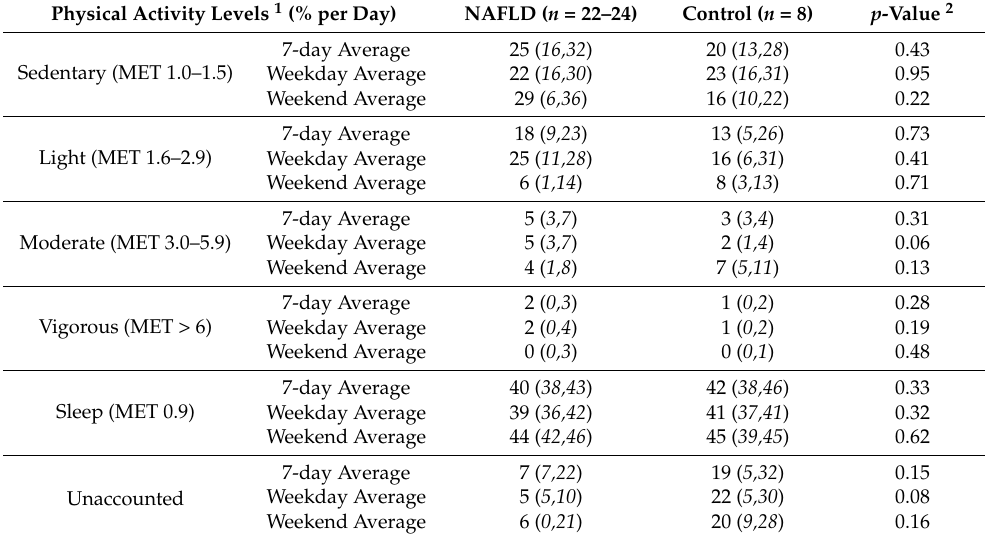
Table 4. Physical Activity Levels expressed as amount of time (%) per day recorded using 7-day activity